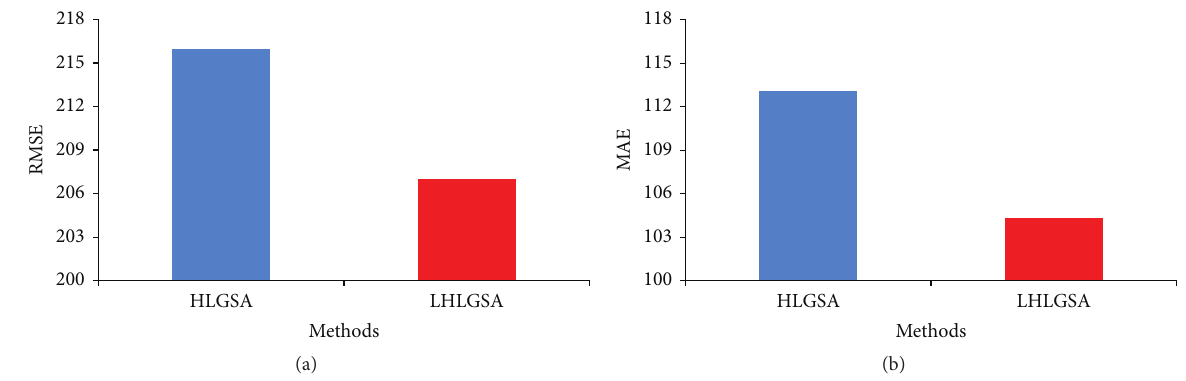
Figure 16: Comparison of overall errors of LHLGSA and HLGSA models for estimating river flow of Shyok catchment using Astore catchment’s river